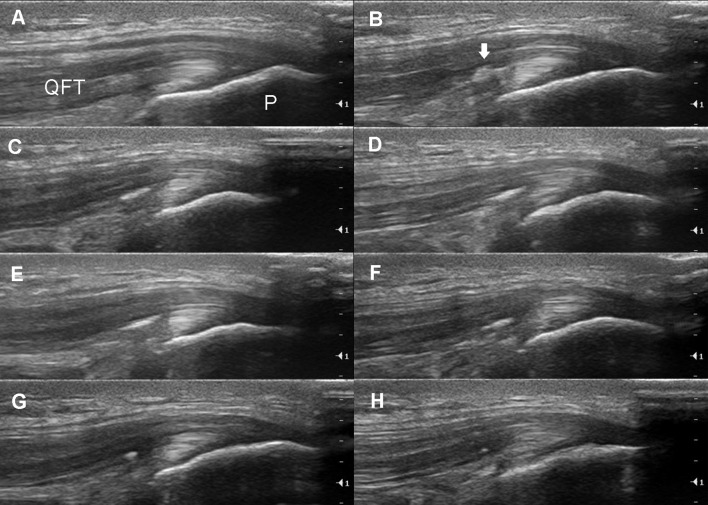
Longitudinal ultrasound imaging of the same subject. (A) The normal right quadriceps femoris tendon (QFT) and its insertion into the patella (P). (B) Intratendinous collections of bright foci (arrow) can already be clearly visualized after two jumps. Dynamic changes in the intratendinous foci can be seen after 15 (C), 40 (D), 75 (E), and 100 (F) jumps and 20 min (G) and 40 min (H) after exercise.